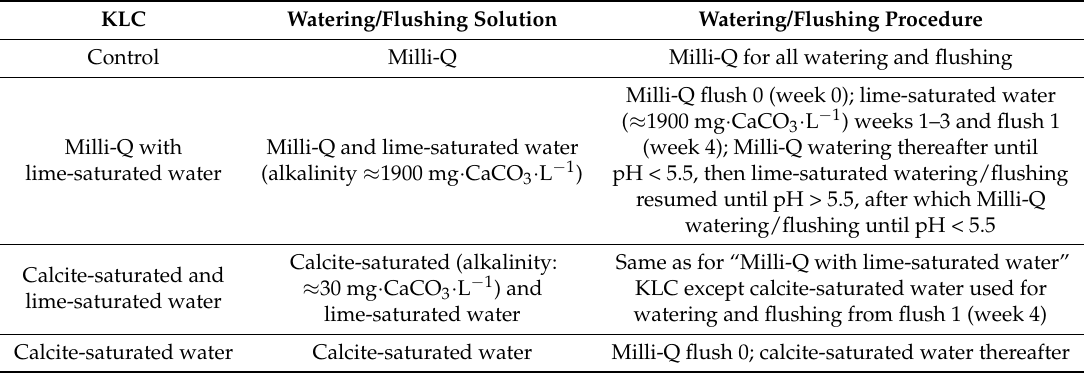
Table 1. Details of KLC setup and watering/flushing protocols (see Supplementary Materials Section S1